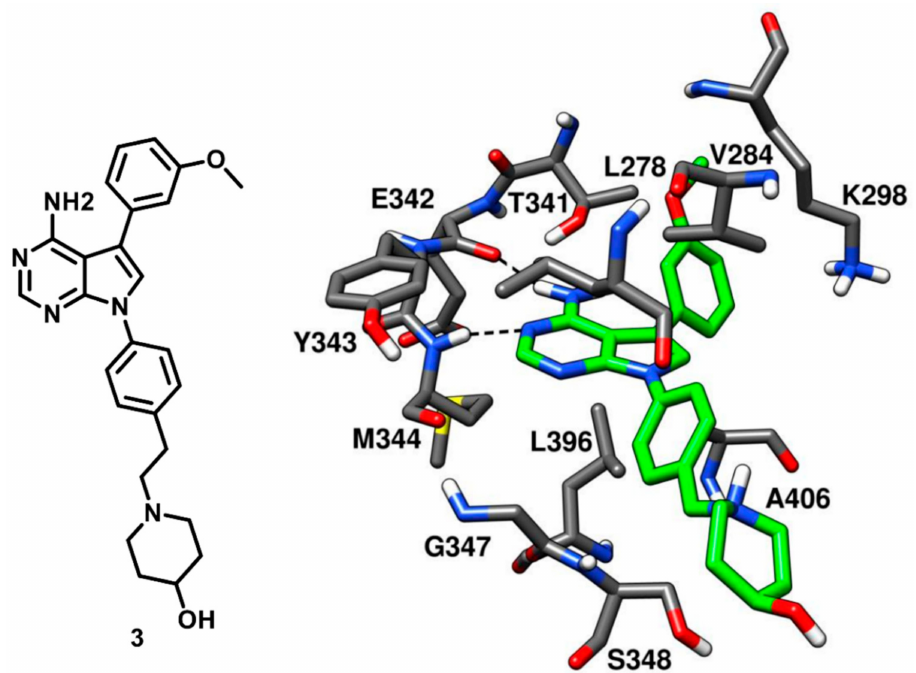
Figure 5. 2D structure of 3 and X-ray structure of c-Src kinase in complex with 3 (PDB ID: